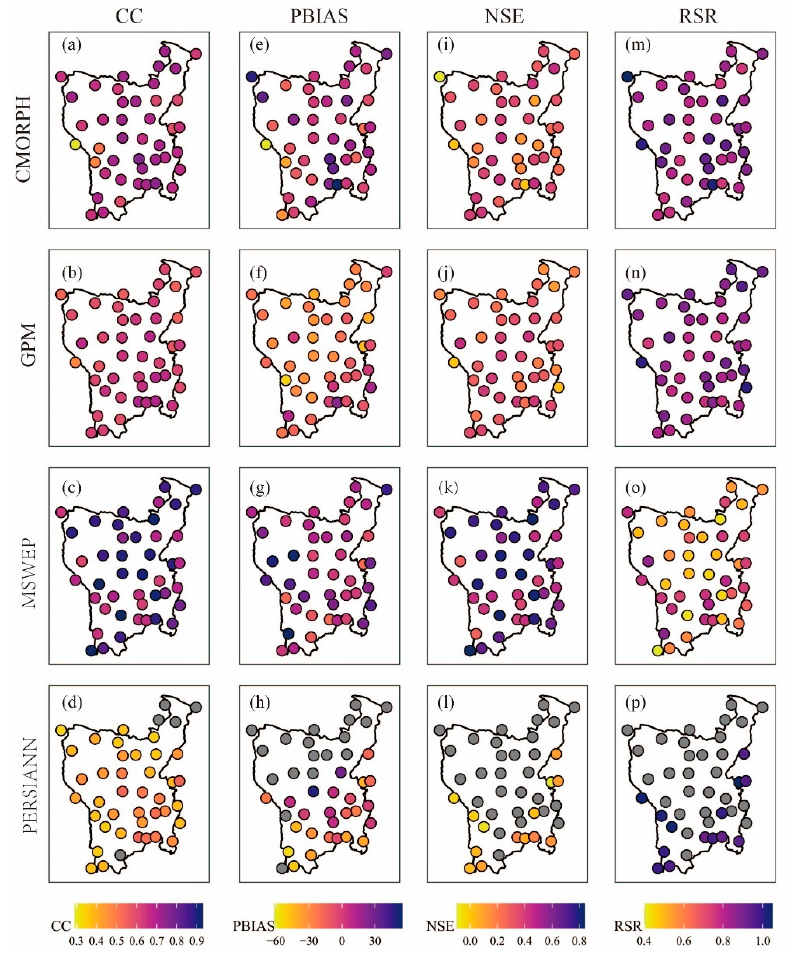
Figure 4. Spatial distribution of CC ( a – d ), PBIAS ( e – h ), NSE ( i – l ), and RSR ( m – p ) for four satellite rainfall products over HMR. Gray dots indicate that the value is outside the indicated range.